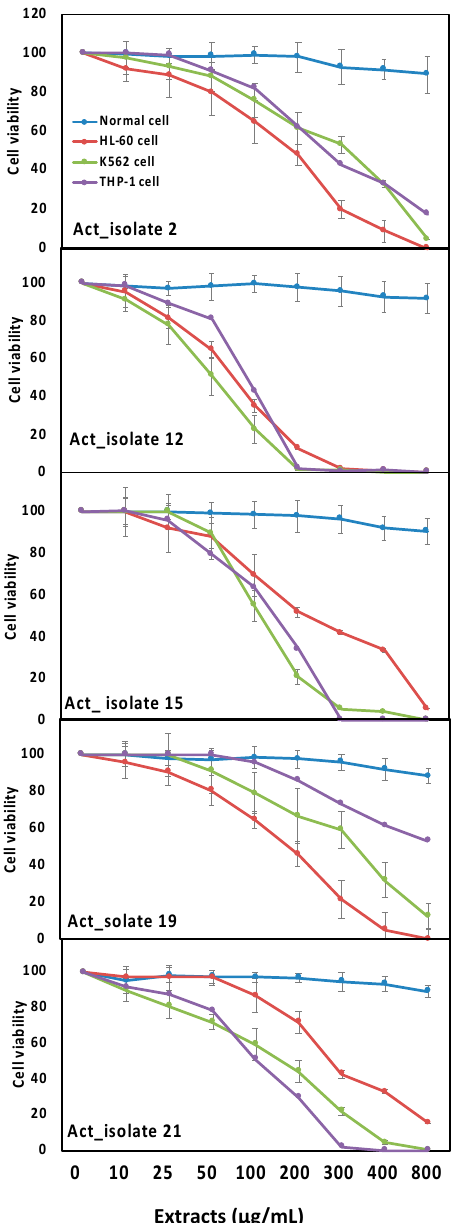
Figure 4. The activity of 90% ethanol extracts (0, 10, 25, 50, 100, 200, 300, 400, 800 µ g/mL) of five most biologically active Streptomyces isolates (Act 2, Act 12, Act 15, Act 19 and Act 21) against leukemia cell viability (HL-60, K562 and THP-1). Data are represented by the means of at least 3 replicates and error bars represent standard deviations.